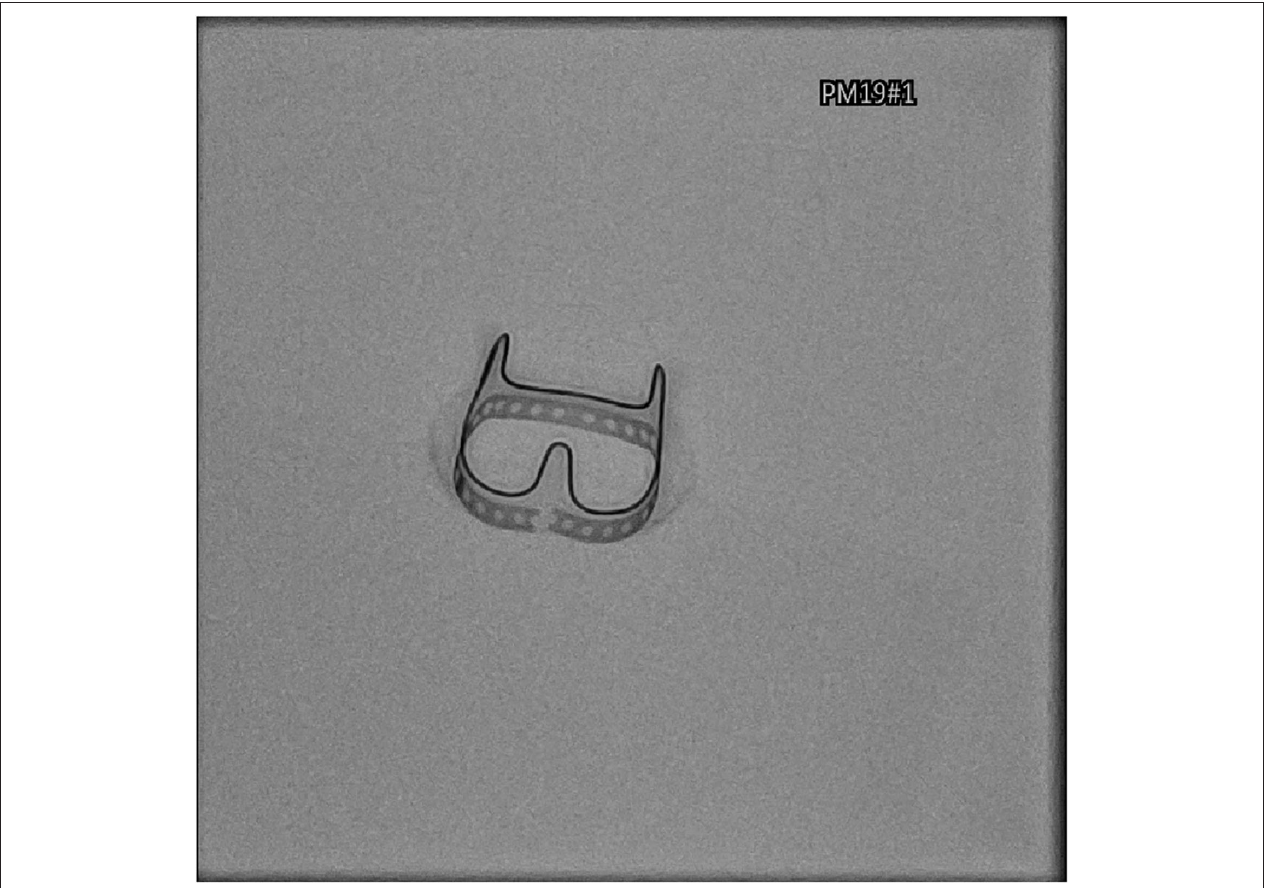
FIGURE 2 | Fluoroscopic confirmation of successful bioprosthetic valve